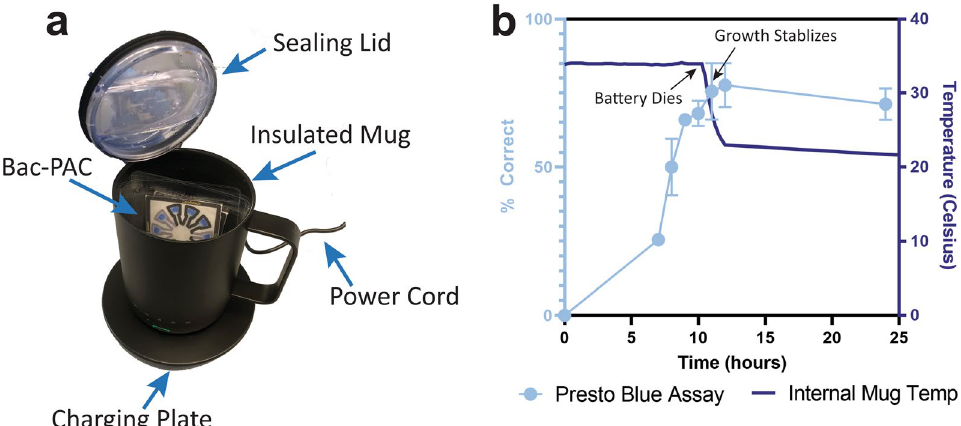
Figure 4. SmartMug incubator. ( a ) Picture of the Smart Mug rechargeable incubator system. ( b ) Accuracy of Bac-PACs in Smart Mug and temperature over 24 h when on battery power. Error bars show standard error of the